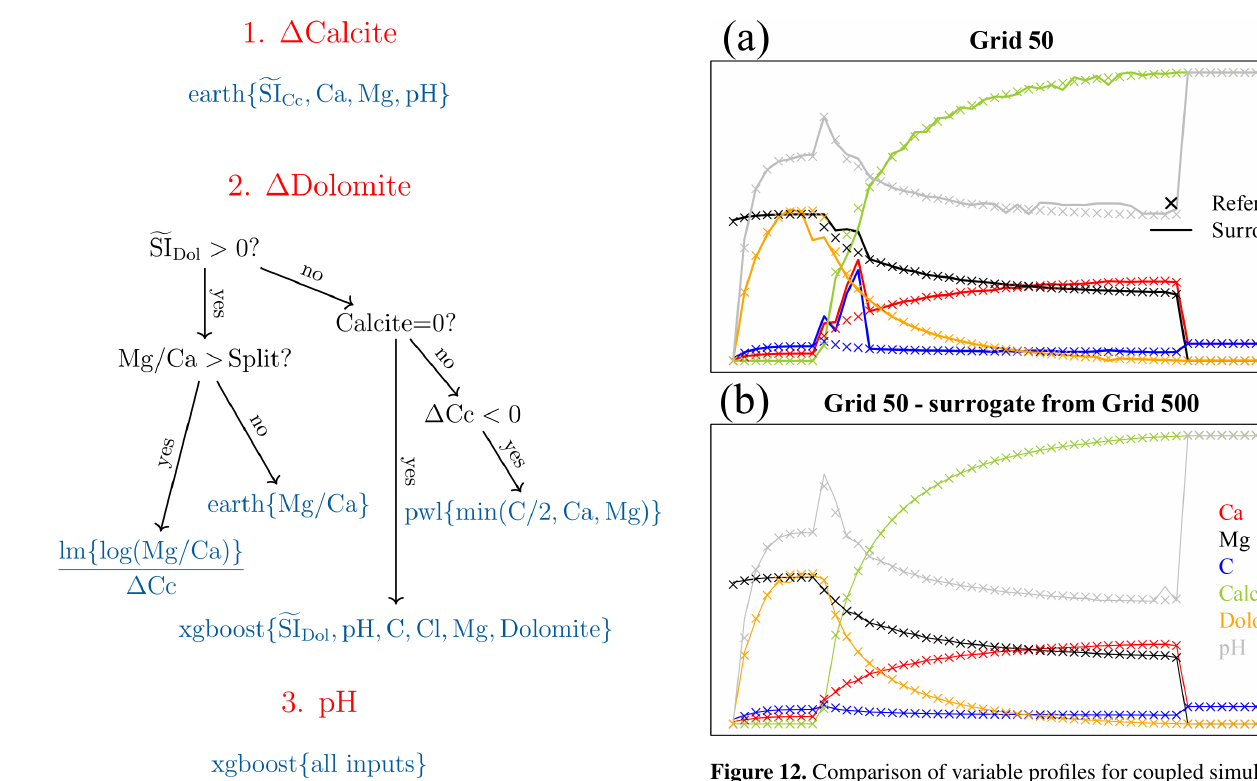
Figure 11. Decision tree for the surrogate based on physical inter- pretation of the training dataset. The engineered features are used as splits and as predictors for different regressions depending on the region of parameter space. The abbreviations “lm” and “pwl” respectively stand for “linear model” and for “piecewise linear” re- gression.